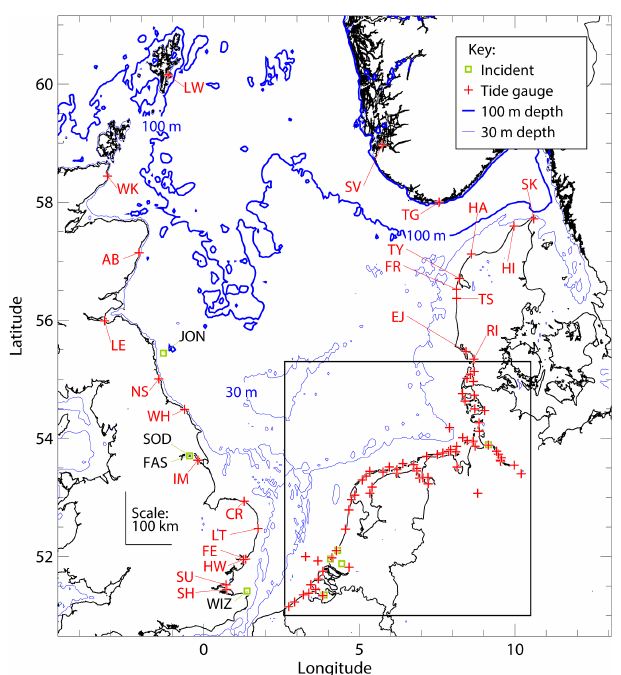
Figure 3. Location of tide gauges analyzed in this study and of North Sea maritime incidents that were reported over the 2d period 18–19 January 2007. For presentation clarity, the information in the inset box covering the south eastern North Sea is shown in Fig. 4. The abbreviation codes for the tide gauges and maritime incidents are explained in Tables S9.1 and S14.1.